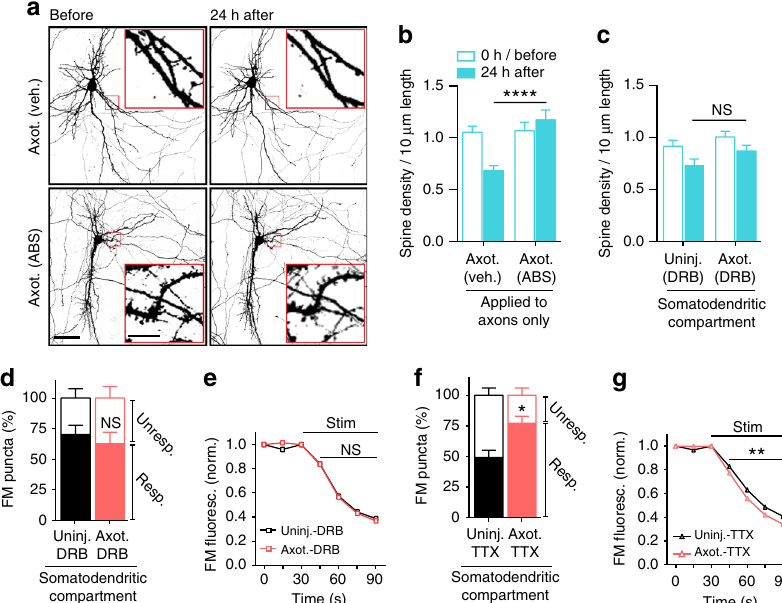
Fig. 6 In fl uence of local activity and transcription on the initiation of injury-induced synaptic remodeling. a Representative images of neurons within micro fl uidic chambers retrograde labeled with eGFP rabies virus ( inverted grayscale ) before and 24 h post-axotomy with vehicle or local activity blockade solution (ABS) applied to axons for 1 h during axotomy. Inset shows zoomed in dendritic regions. Image and inset scale bars , 50 and 5 µ m, respectively. b Quanti fi cation of before and after spine density data described in a . Axotomy (vehicle): n = 29 dendrites; 5 neurons; 3 chambers over 3 experiments; #spines/TDL: 437/4185 µ m (before), 274/3868 µ m (after). Axot. (ABS): n = 33 dendrites; 5 neurons; 3 chambers over 3 experiments; #spines/TDL: 426/ 3889 µ m (before), 446/3700 µ m (after). c Quanti fi cation of spine density changes following application of transcription blocker (DRB) to the somatodendritic compartment for 1 h during axotomy within micro fl uidic chambers. DRB (uninj.): n = 27 dendrites; 6 neurons; 3 chambers over 3 experiments; #spines/TDL: 362/4186 µ m (0 h), 262/3934 µ m (24 h after). DRB (axot.): n = 28; 6 neurons; 3 chambers over 3 experiments; #spines/TDL: 343/3414 µ m (before) 283/3248 µ m (after). b , c Unpaired two-tailed t -test. d Percentage of responsive and unresponsive FM puncta at 48 h post- axotomy. n = 6 neuron fi elds/chambers per condition over 3 experiments. Unpaired two-tailed t -test for % responsive. e FM 5 – 95 unloading following 1 h application of DRB during axotomy/control. Uninj. DRB: n = 1580 puncta; 6 chambers per condition over 3 experiments. Axot. DRB: 2213 puncta; 6 chambers per condition over 3 experiments. f Percent of responsive and unresponsive puncta at 48 h post-axotomy following application of TTX to